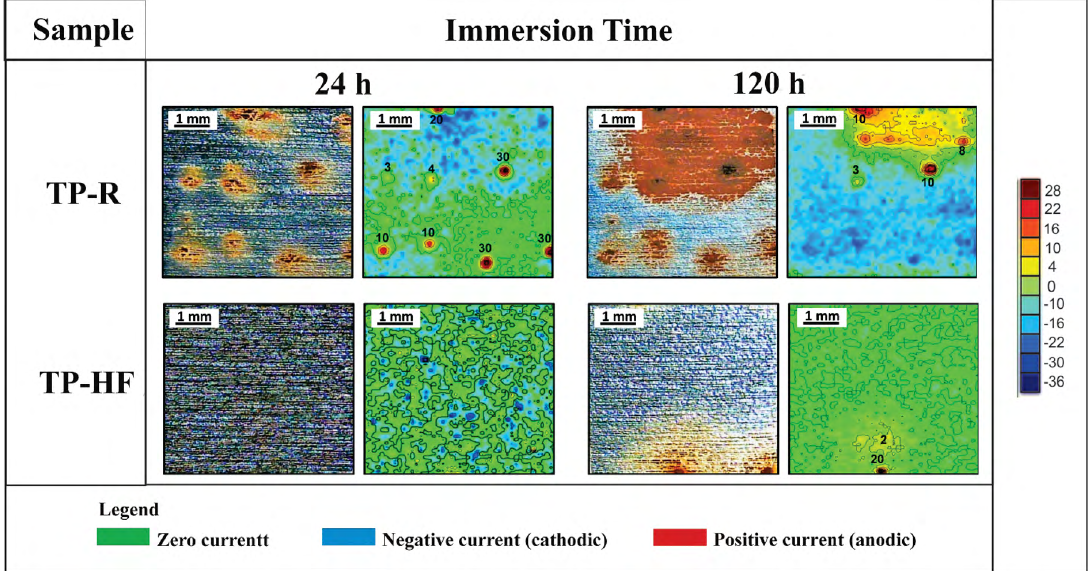
Figure 14. SVET micrographs of the samples, after 24 h and 120 h of immersion in 0.05 M